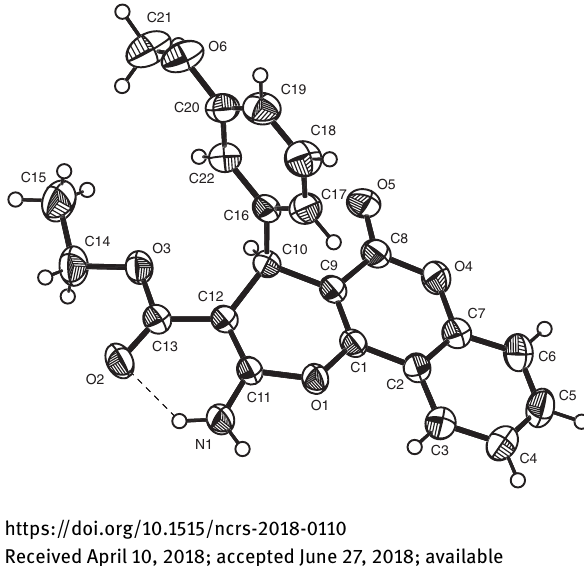
Table 1: Data collection and handling.